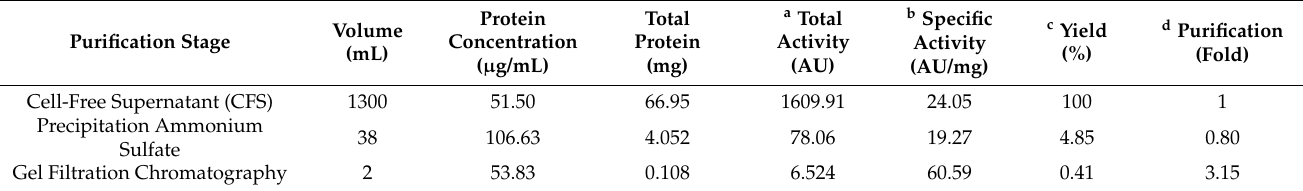
Table 2. The antibacterial activity of bacteriocin against Salmonella sp. and S. aureus .